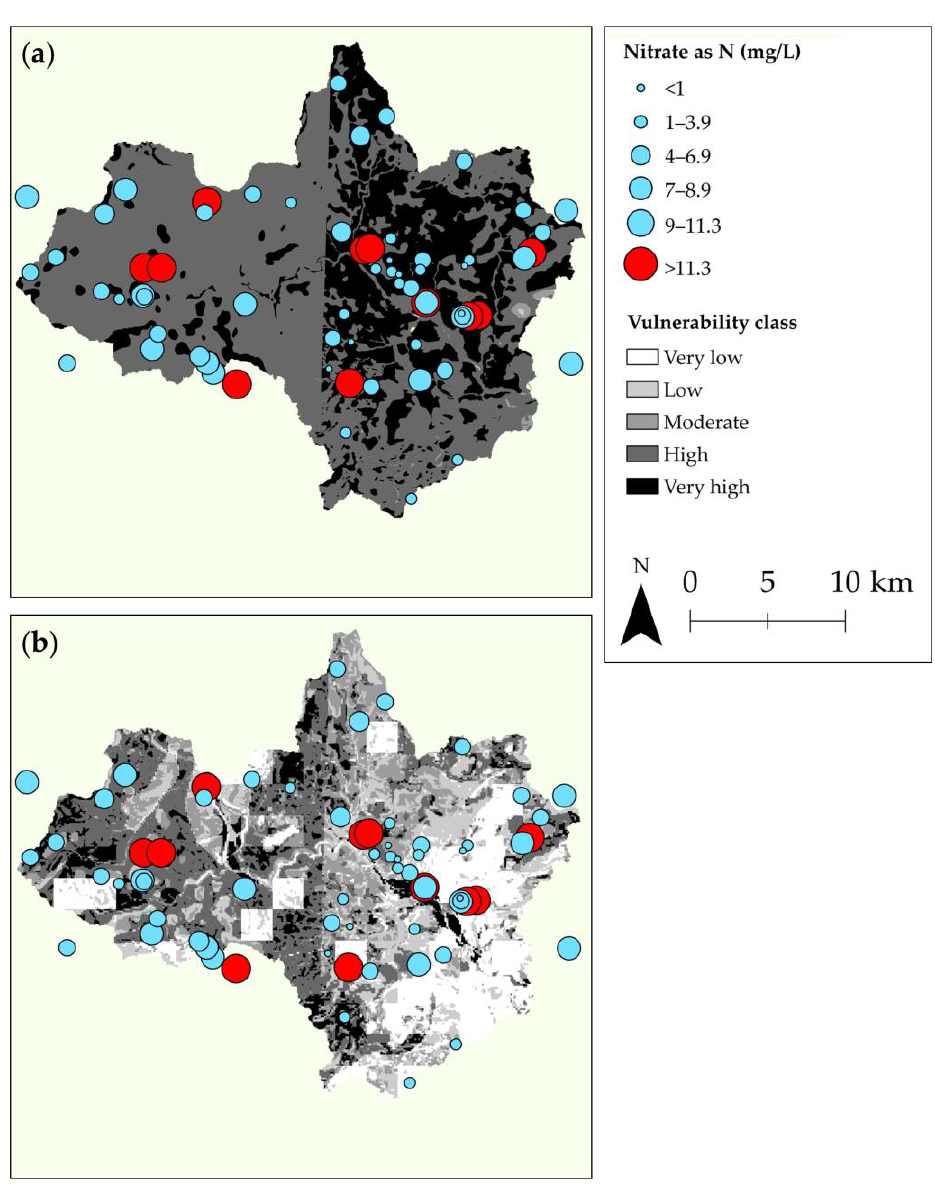
Figure 3. Spatial distribution of groundwater nitrate concentrations taken from SEPA Ythan moni- toring stations and private water supplies, overlayed onto ( a ) BGS groundwater vulnerability map (Scotland) derived from 1:100,000 scale BGS Digital Data under License (2023/007) British Geological Survey. © and Database Right UKRI. All rights reserved; and ( b ) DRASTIC groundwater vulnerability map for the River Ythan catchment [41].